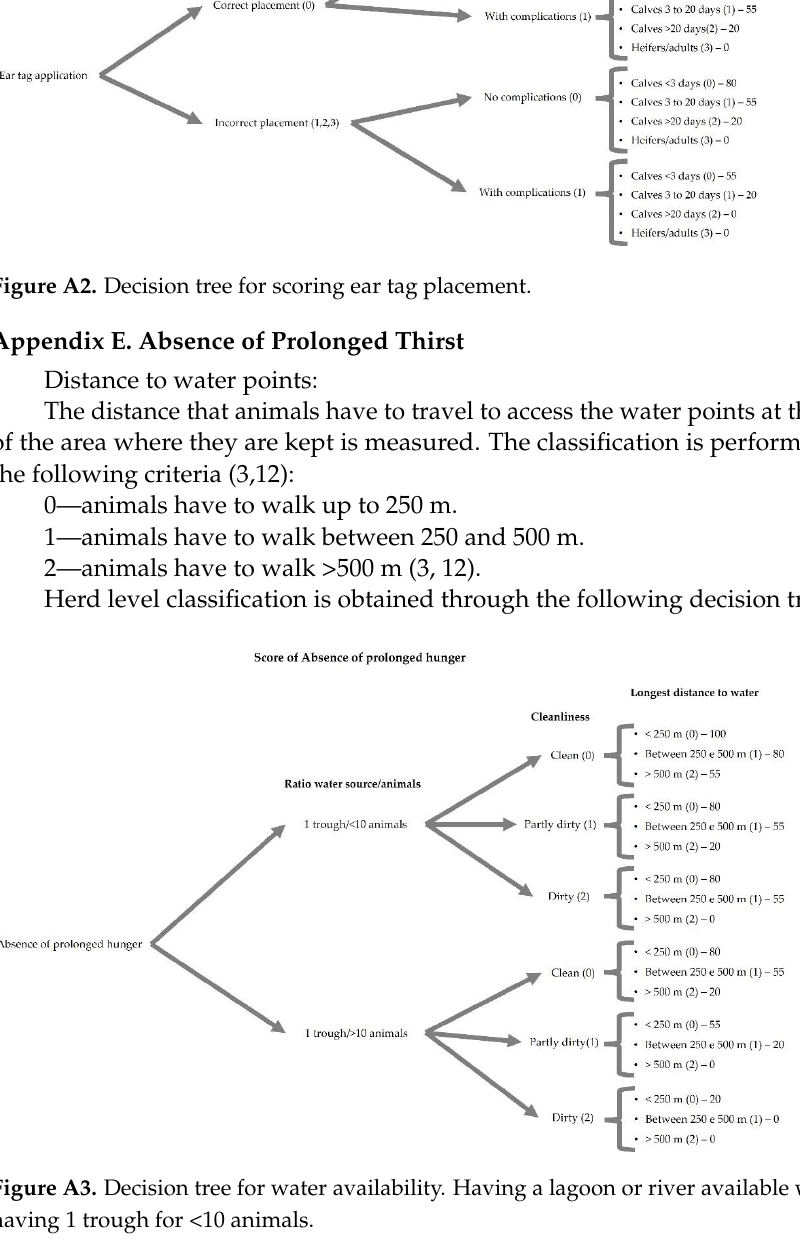
Figure A1. Ear tag application scoring (adapted from Richards and Gosz, n. d. [32]).